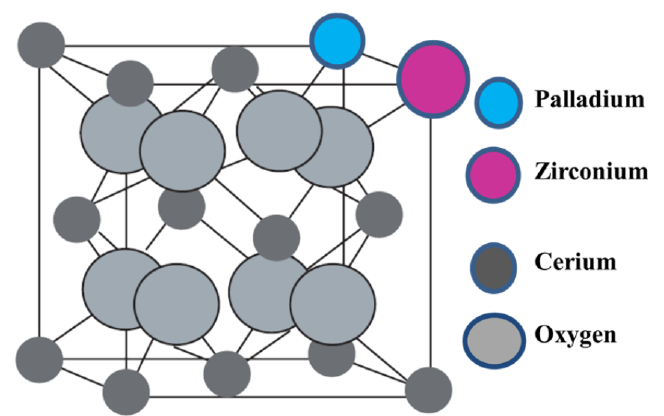
Figure 1. Illustration of substitution in the fluorite structure of cerium.